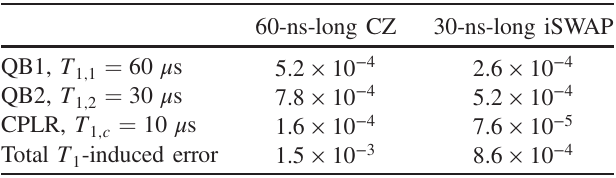
TABLE VII. T 1 contributions to the average gate errors of a 60-ns-long CZ and a 30-ns-long iSWAP gate. Each T 1 contri- bution is computed by taking the difference between the gate errors in the presence and the absence of corresponding energy relaxation. We find that the sum of individual T 1 contributions is approximately equal to the total T 1 -induced error computed from a separate simulation that takes all possible relaxations into account (purple circles in Fig. 35).